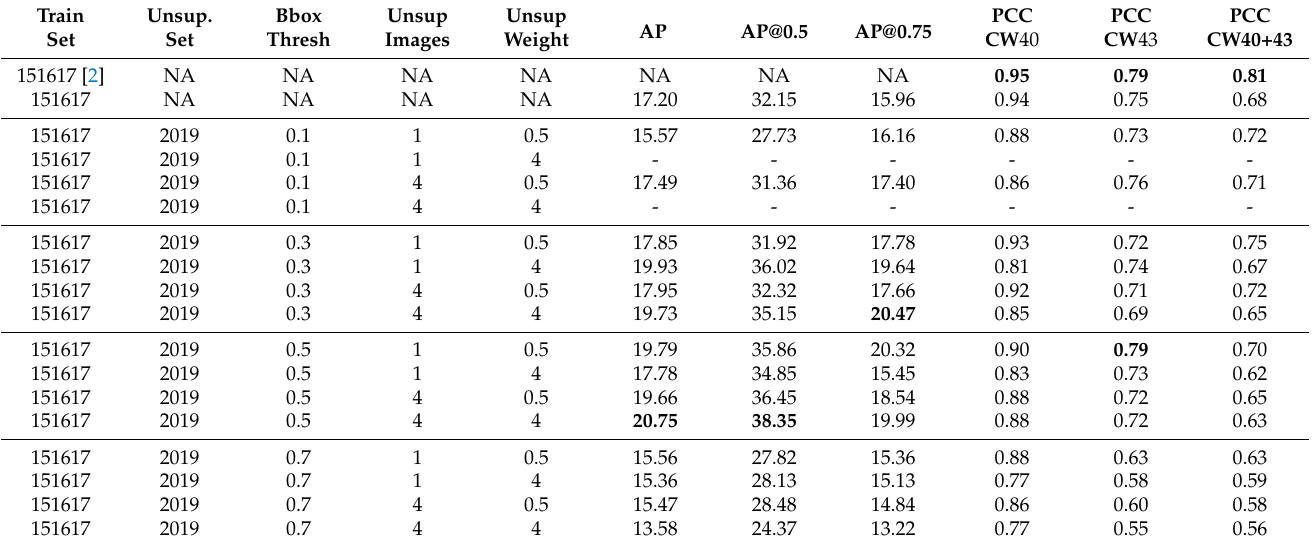
Table 8. Results for SSL-trained models for models with various hyper-parameters on the 151617 annotated dataset together with unannotated images from a harvest from 2019. Additional results are also shown for baseline fully supervised models in the first